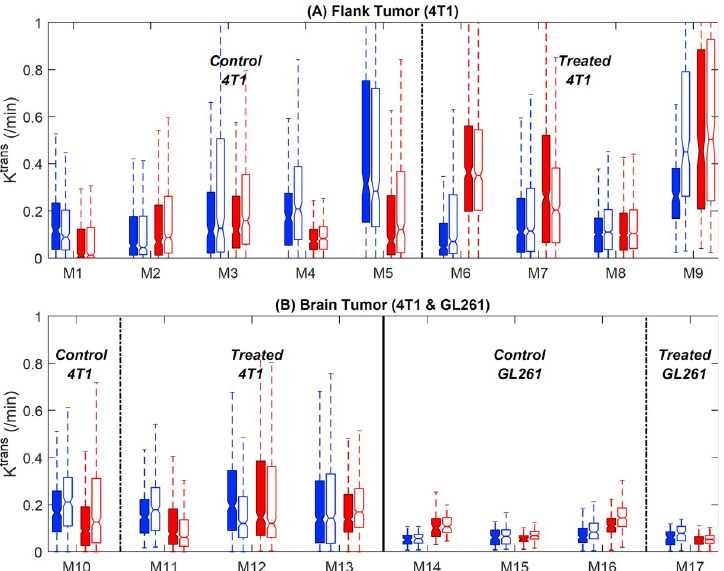
Fig 3. Comparison of K trans values estimated for the voxels in tumor ROIs using the ACE-MRI (filled boxes) and DCE-MRI (open boxes) methods with pre-treatment (blue) and post-treatment (red) data. (a) Flank tumors (4T1: M1-M9). (b) Brain tumors (4T1: M10-M13 and GL261: M14-M17).